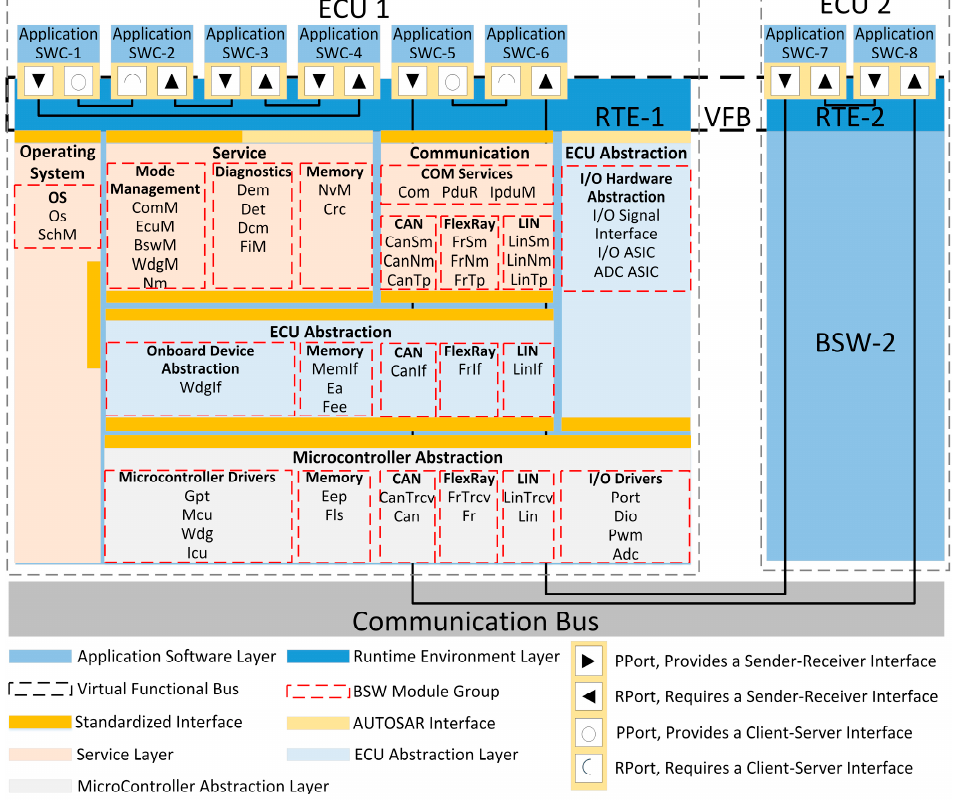
Figure 2. Detailed AUTOSAR software architecture.